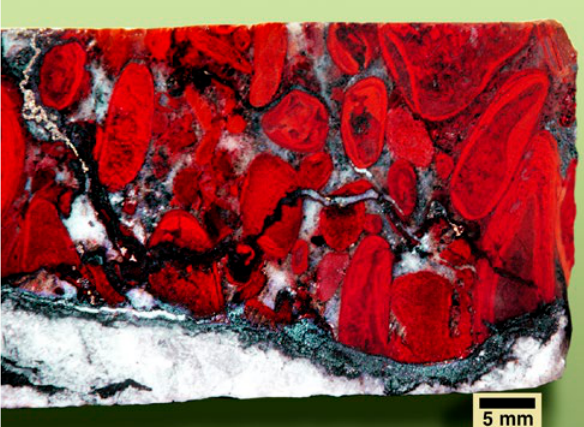
Figure 63. Brilliant jasper oolites occur in core through a quartz lode at the Abra Prospect, Jillawarra, W.A. Jasper is metacolloidal and a soft precursor stage of these overgrowths on accretionary siliceous nuclei is indicated by their plastic deformation, mutual indentation, and fragmentation. They are cut by later stylolitic quartz veinlets which meandered through the soft gelatinous silica precursors.